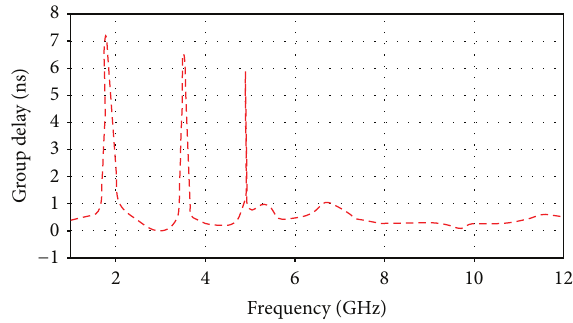
Figure 12: Group delay of the proposed triple band-notched antenna.